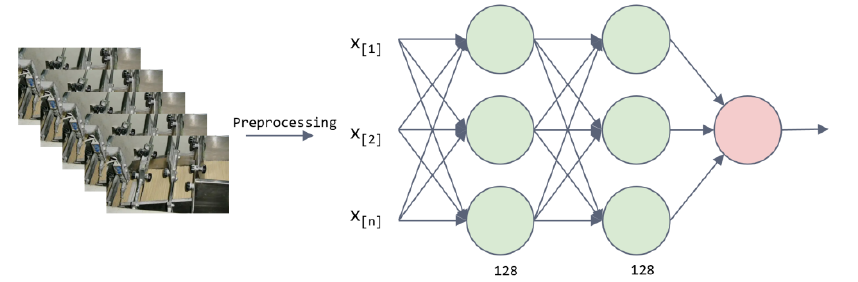
Figure 9. Structure of the neural network used in this paper.